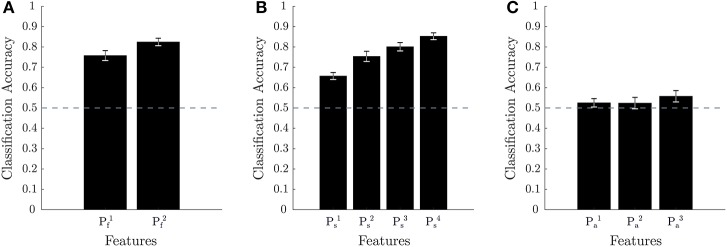
Cross-validation results for classification accuracy. 10-fold cross-validation results across 18 subjects with performance averaged across electrodes are shown in (A,B) for mental fatigue and stress, respectively. 3-fold cross-validation results across nine subjects with performance averaged across electrodes are shown in (C) for attention. The error bars for (A–C) are the standard error of the mean across subjects and the dotted line represents random chance accuracy.